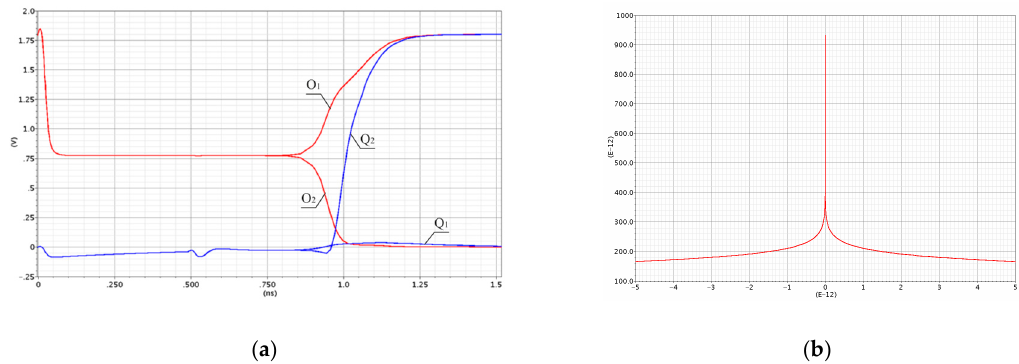
Figure 26. Metastable states at output O 1 and O 2 of RS latch ( a ). Response time of MUTEX vs. time interval at MUTEX input ( b ).